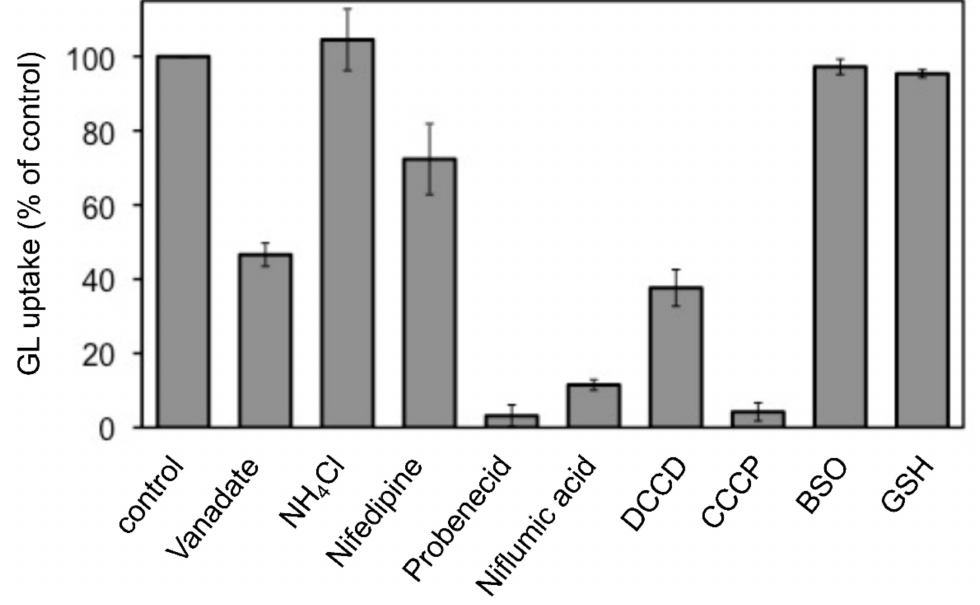
Figure 3. Effect of various transport inhibitors on GL uptake by cultured cells of G. glabra . Either nifedipine (200 µ M), NH 4 Cl (10 mM), vanadate (2 mM), probenecid (200 µ M), niflumic acid (50 µ M),